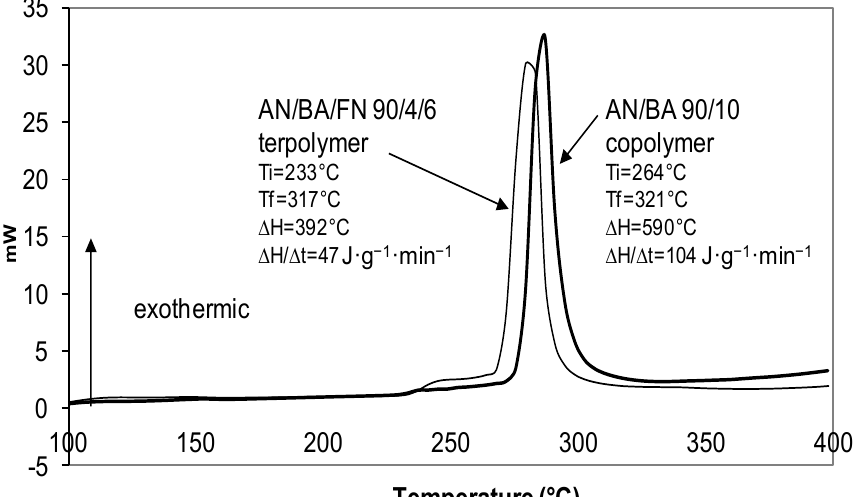
Figure 4. DSC thermograms of AN/BA 90/10 copolymer and AN/BA/FN 90/4/6